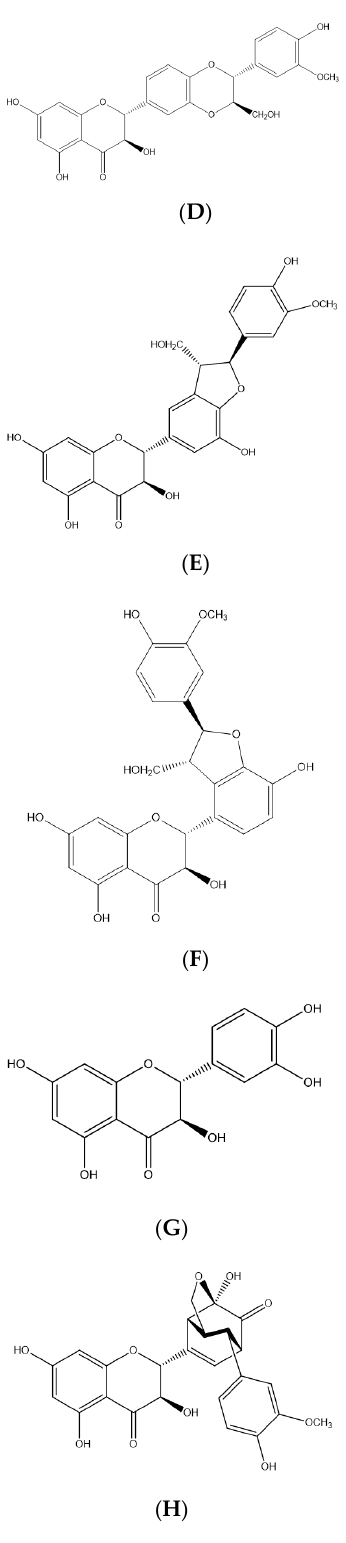
Figure 9. The structure of the components of Silymarin. Legend: ( a ) silibinin A ( b ) silibinin B, ( c ) isosilybin A ( d ) isosilybin B, ( e ) silychristin, ( f ) isosilychristin, ( g ) silydianin and ( h )